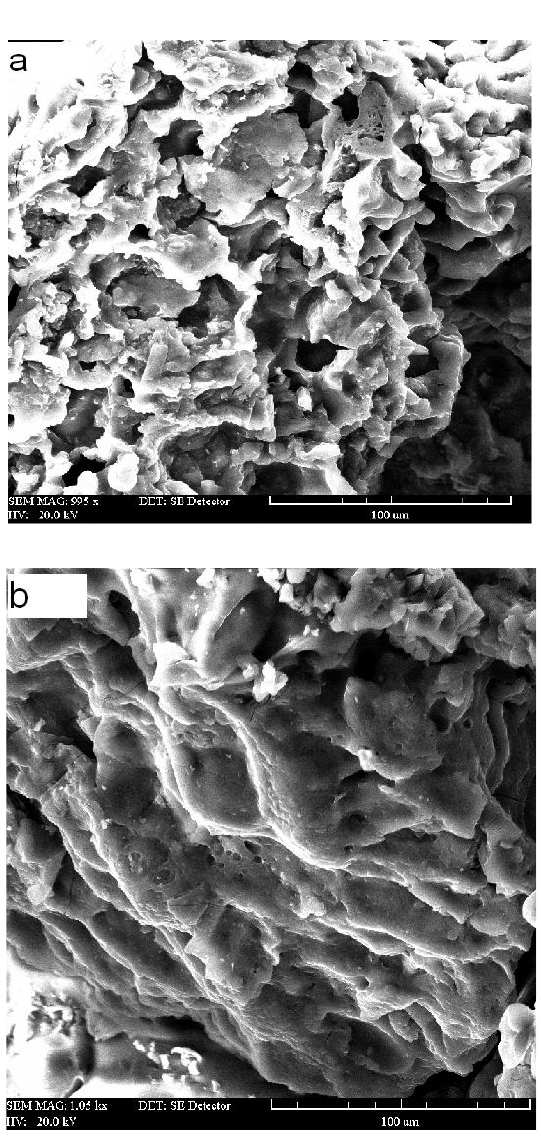
Figure 2. SEM images of (a)PASAC and (b) ZASAC (magnification: